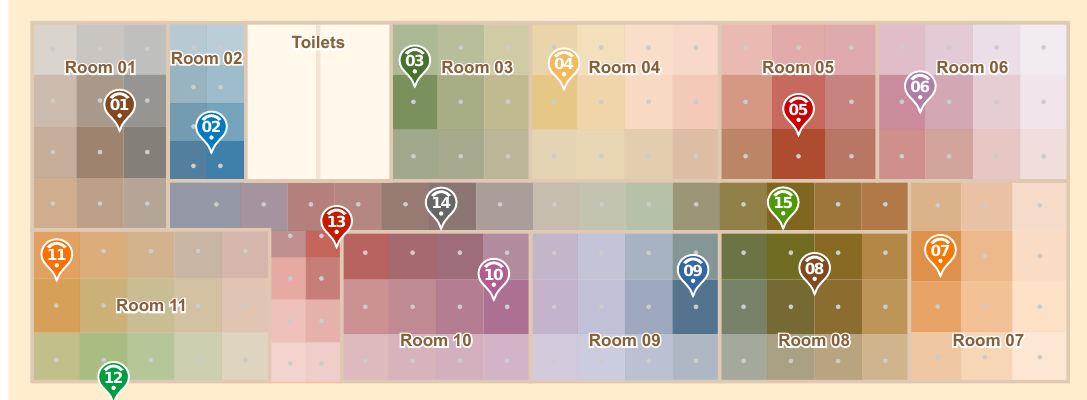
Figure 6. Signal characterization of the scenario based on the measurements made